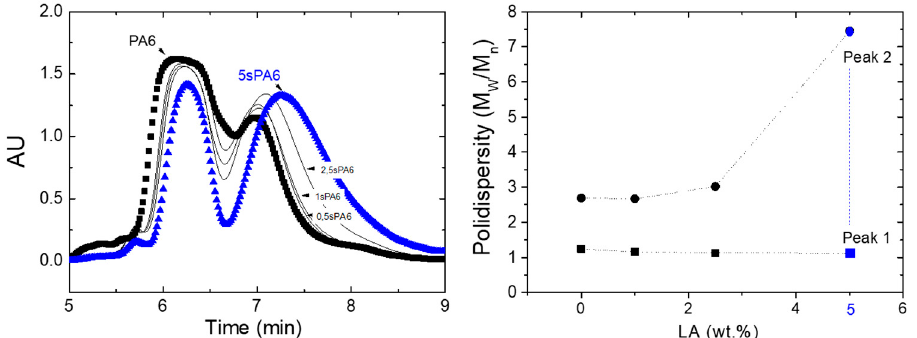
Figure 4. ( Left ) SEC curves of the star-branched polyamides. ( Right ) Polydispersity of the peaks for Figure 4. (Left) SEC curves of the star-branched polyamides. (Right) Polydispersity of the peaks for the bimodal distribution of the star-branched the bimodal distribution of the star-branched polyamides.